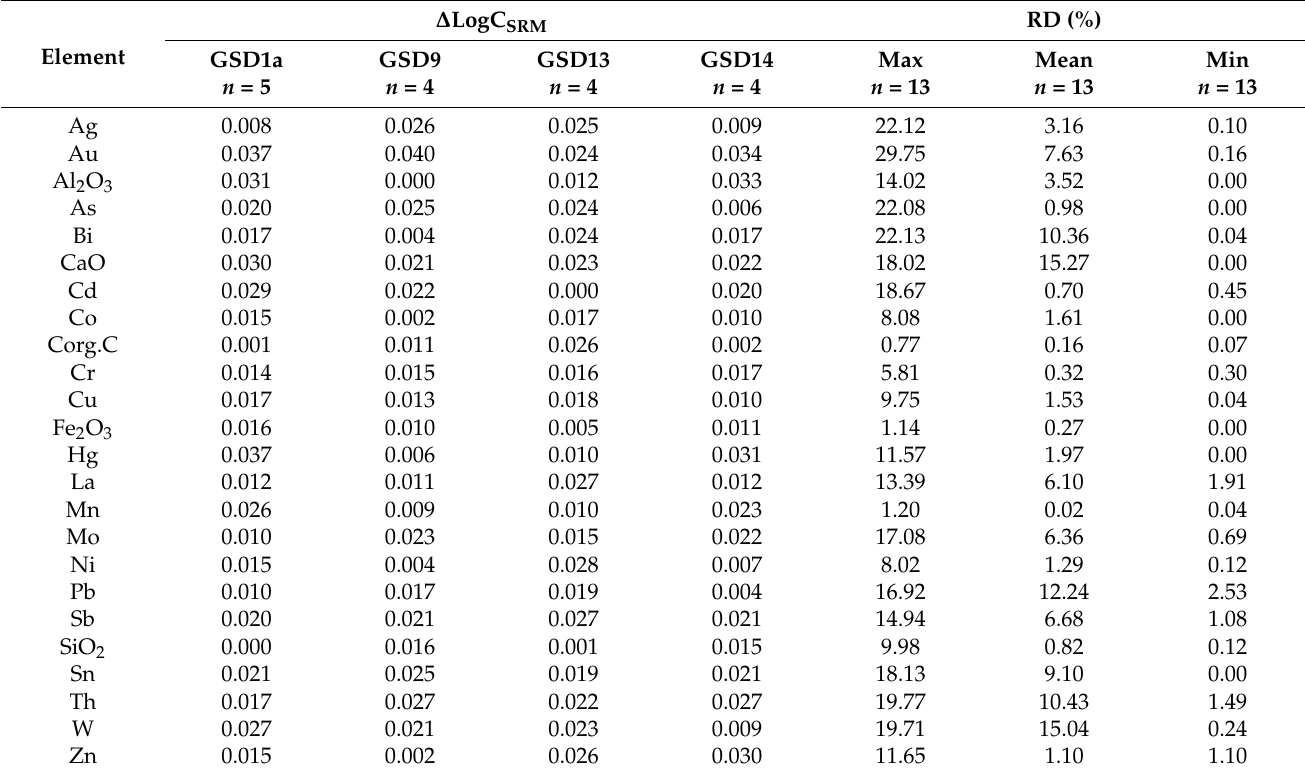
Table 1. Analysis of precision and quality control